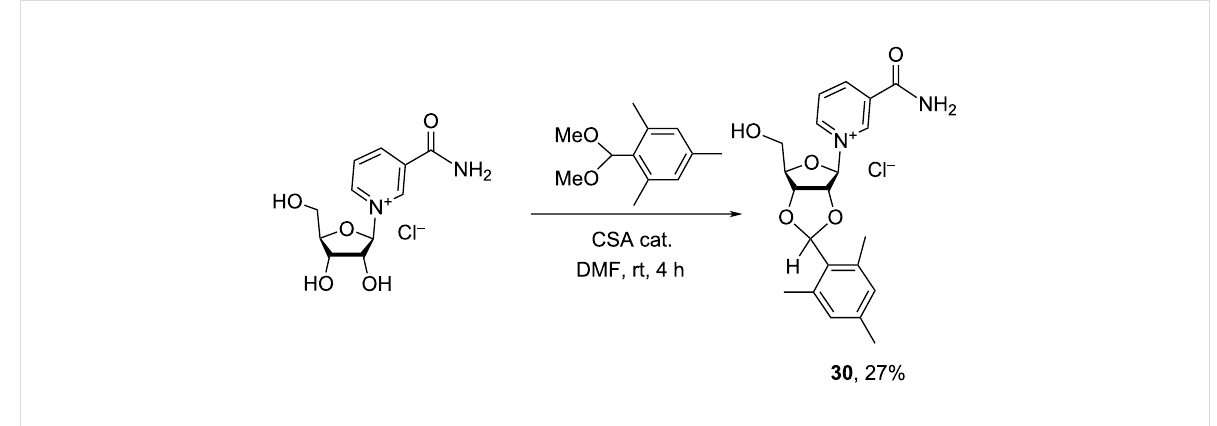
Scheme 15: Protection of the 2 ′ ,3 ′ -hydroxy groups of NR + Cl – with a mesitylmethylene acetal group.